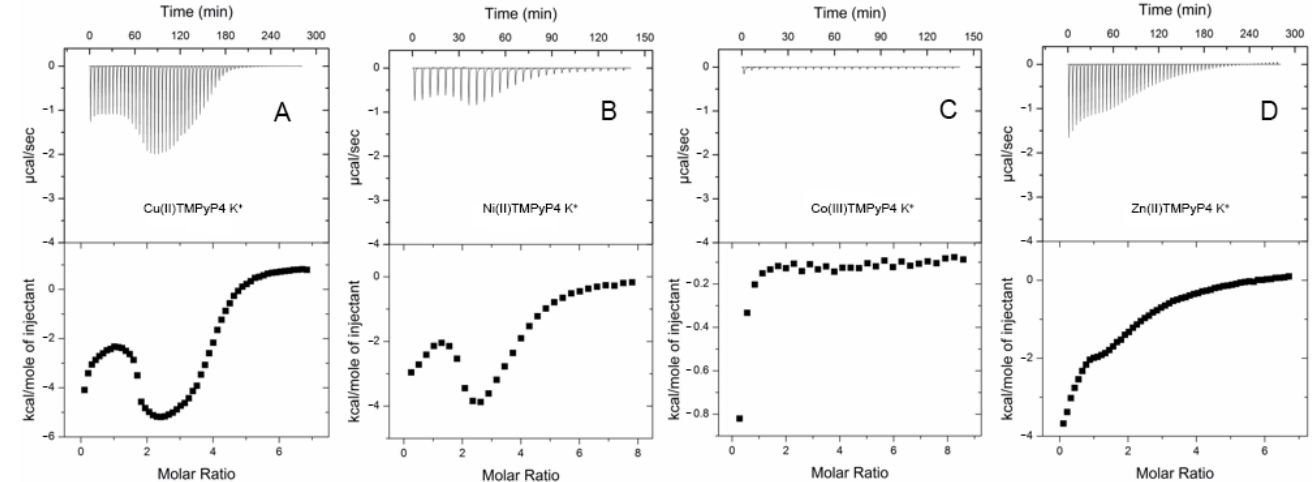
Figure 18. Representative ITC titration profiles for the titration experiments between hTel22 and ( A ) Cu(II)-TMPyP4, ( B ) Ni(II)-TMPyP4, ( C ) Co(III)-TMPyP4, and ( D ) Zn(II)-TMPyP4 in 150 mM K + BPES buffer. ITC experiments were performed of either 28 (10 μ L) or 56 (5 μ L) injections of a dilute ligand solution into a dilute hTel22 DNA solution. Adapted with permission from ref. [182] Copyright 2016 Elsevier.